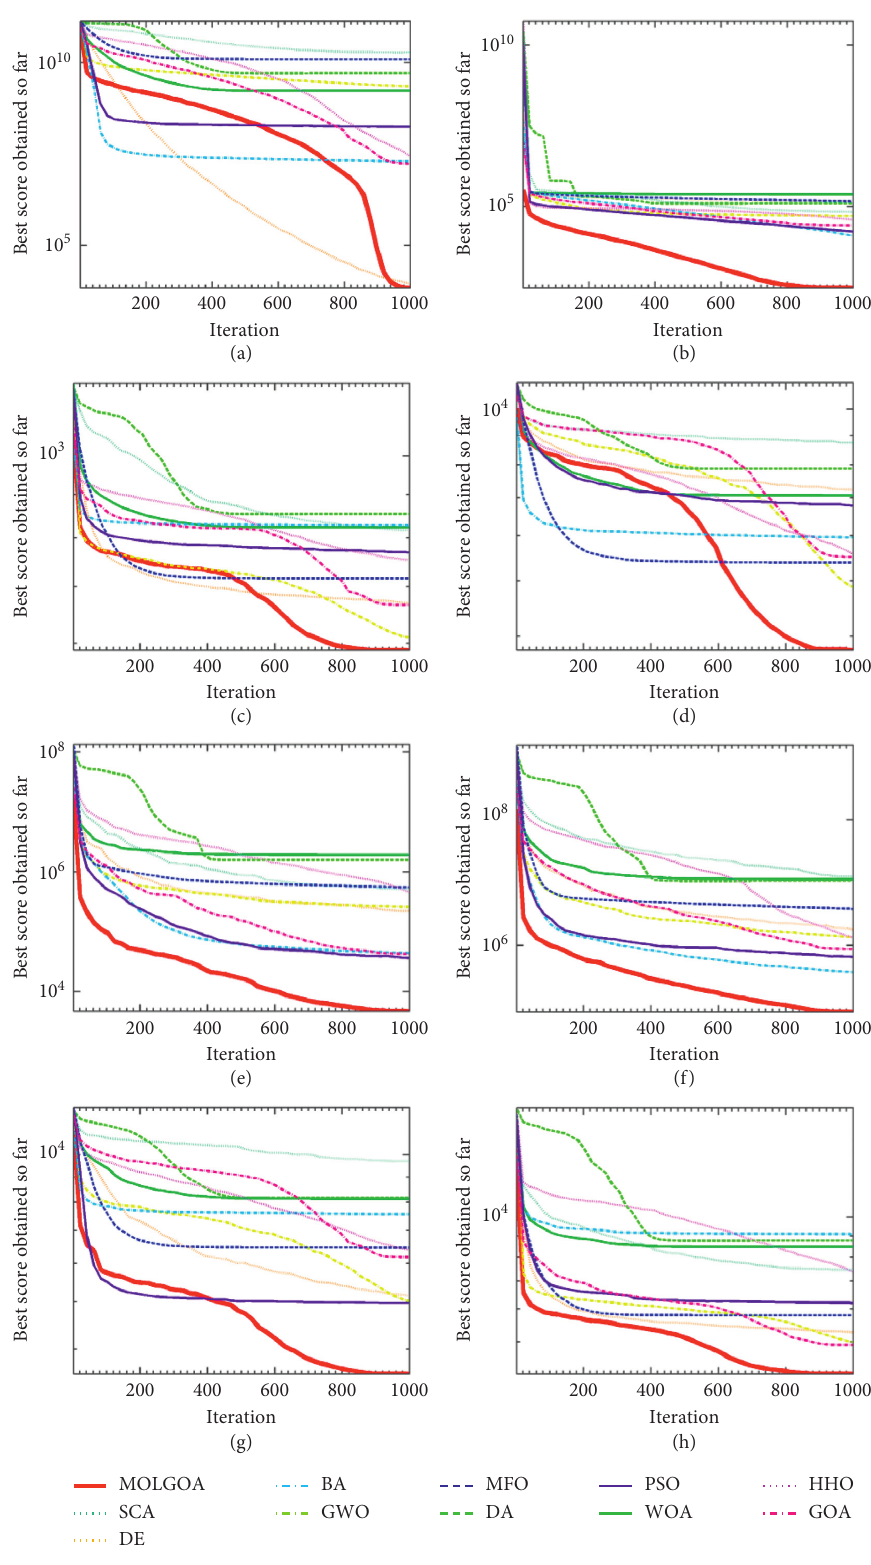
Figure 2: Convergence curve of MOLGOA and other algorithms (first row: (a) F 1, (b) F 3; second row: (c) F 5, (d) F 10; third row: (e) F 14, (f) F 18; fourth row: (g) F 22, (h) F